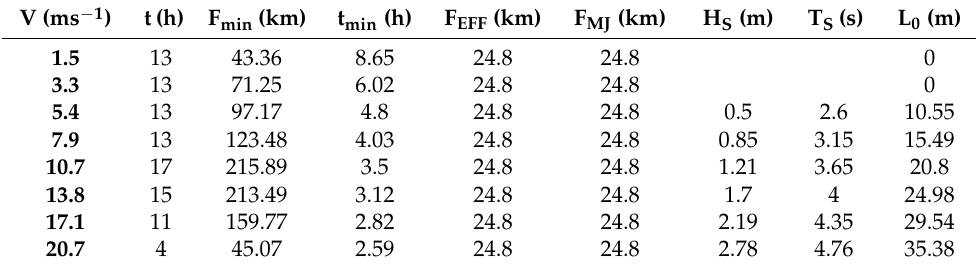
Table 4. Deepwater wave parameters—incident direction SE.